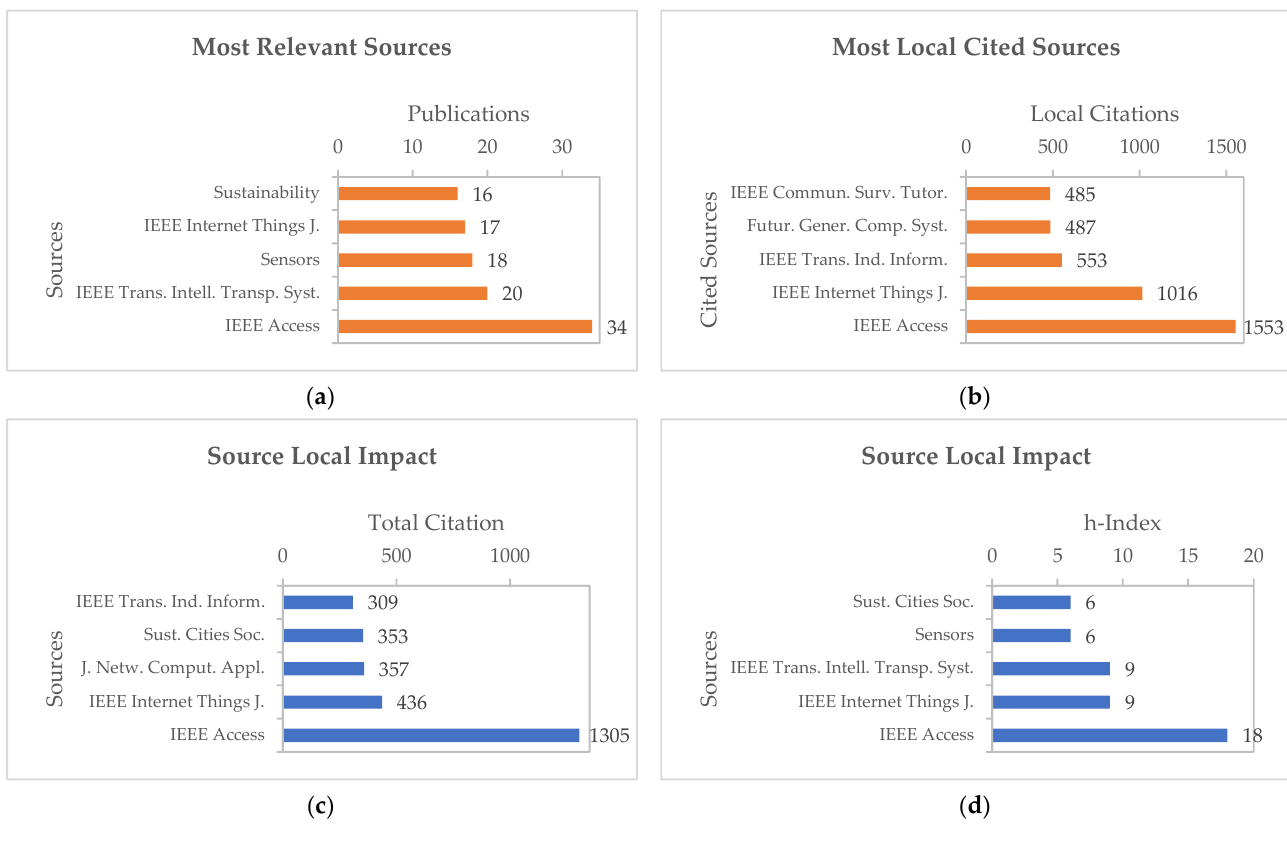
Figure 4. Sources’ influence in terms of: ( a ) number of documents; ( b ) number of local citations (from reference lists); ( c ) total citations; ( d ) h-index. Table 2. The most influential sources in the subject field.